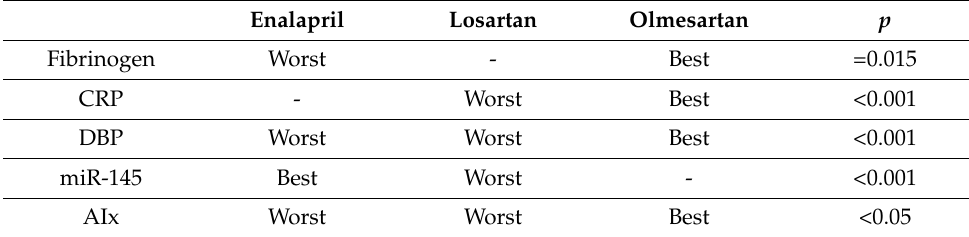
Table 4. Two-by-two comparisons by